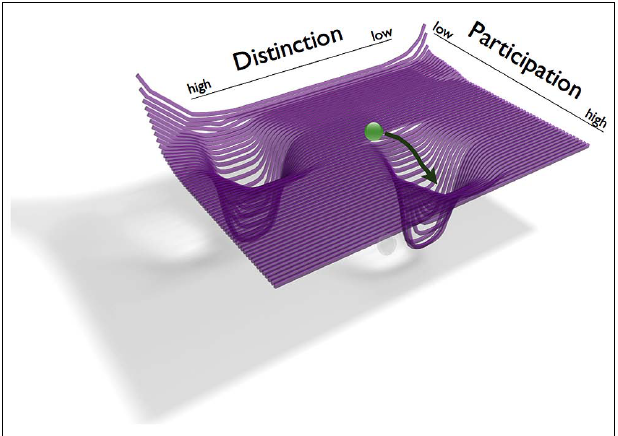
FIGURE 3 | Illustration of the joint phase space of the couple in example 1 . The dyadic phase space is a summation of the individual phase spaces (his low D and high P and her high D and low P, see Figure 1 ).The graphic illustrates the couple’s states during the initial months of the relationship ( t1 ).The green ball symbolizes that they move in a region with higher values of